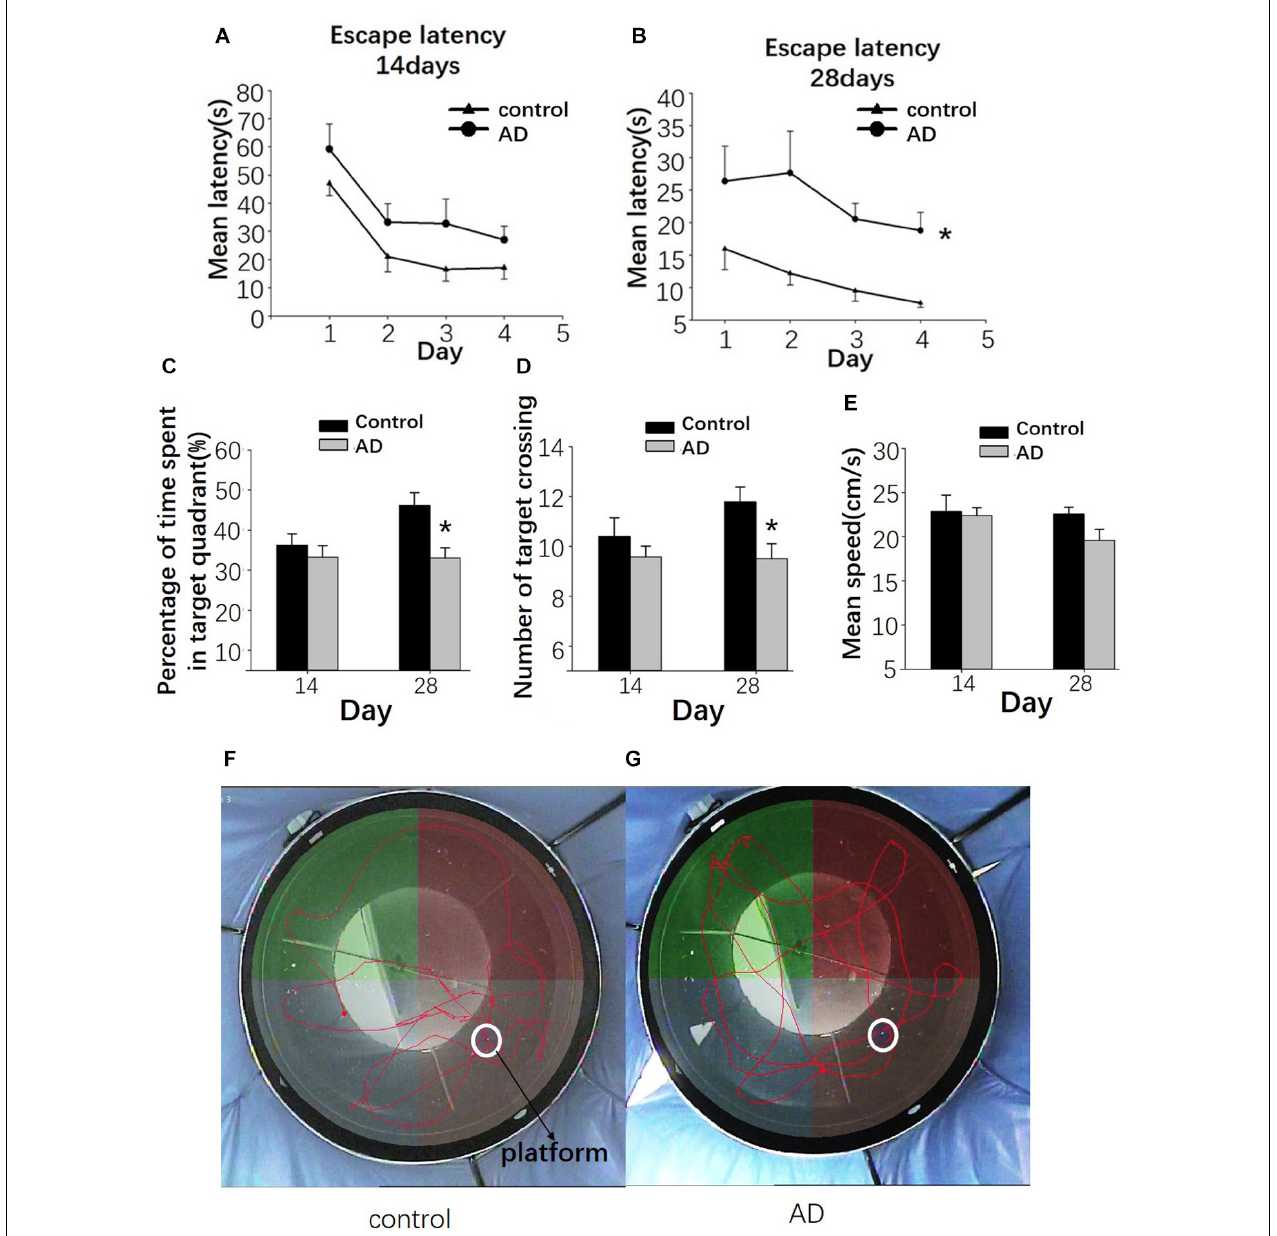
FIGURE 7 | Evaluation of the learning and memory dysfunction in rats of the control and AD groups at 14 and 28 days after A β 25–35 administration by Morris water maze (MWM). The escape latency of control and AD rats (A,B) . (C) Bar charts presenting the percentage of target quadrant crossings. (D) Bar charts presenting the number of target crossings. (E) Bar chart presenting the analysis of swimming speed among rats of the control and AD groups. (F) Tracing of the swimming pattern in the control rats. (G) Tracing of the swimming pattern of the AD rats. n = 6 per group, * P < 0.05, error bar was the standard